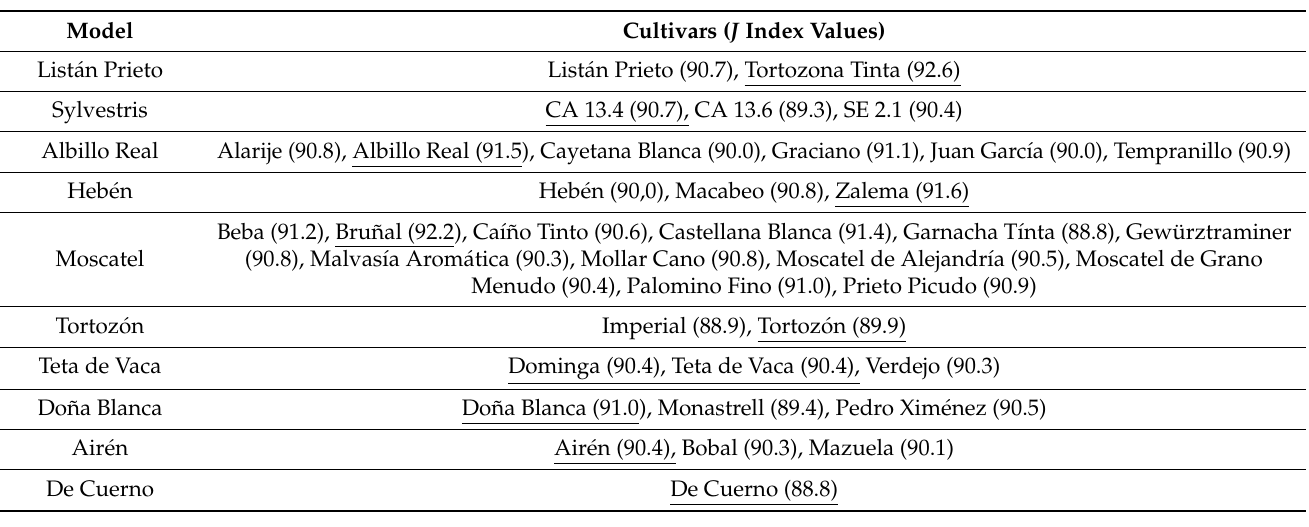
Figure 3. New models used in the classification of 38 representative cultivars of Vitis vinifera L. maintained in El Enc í n and the respective average silhouettes of some of the cultivars. The average silhouettes of the varieties that best fitted each model are represented by a gray area, and the models by a continuous line. Table 1. Mean J index values in the cultivars with their respective models. Underlined: cultivars that gave highest values of J index with each of the